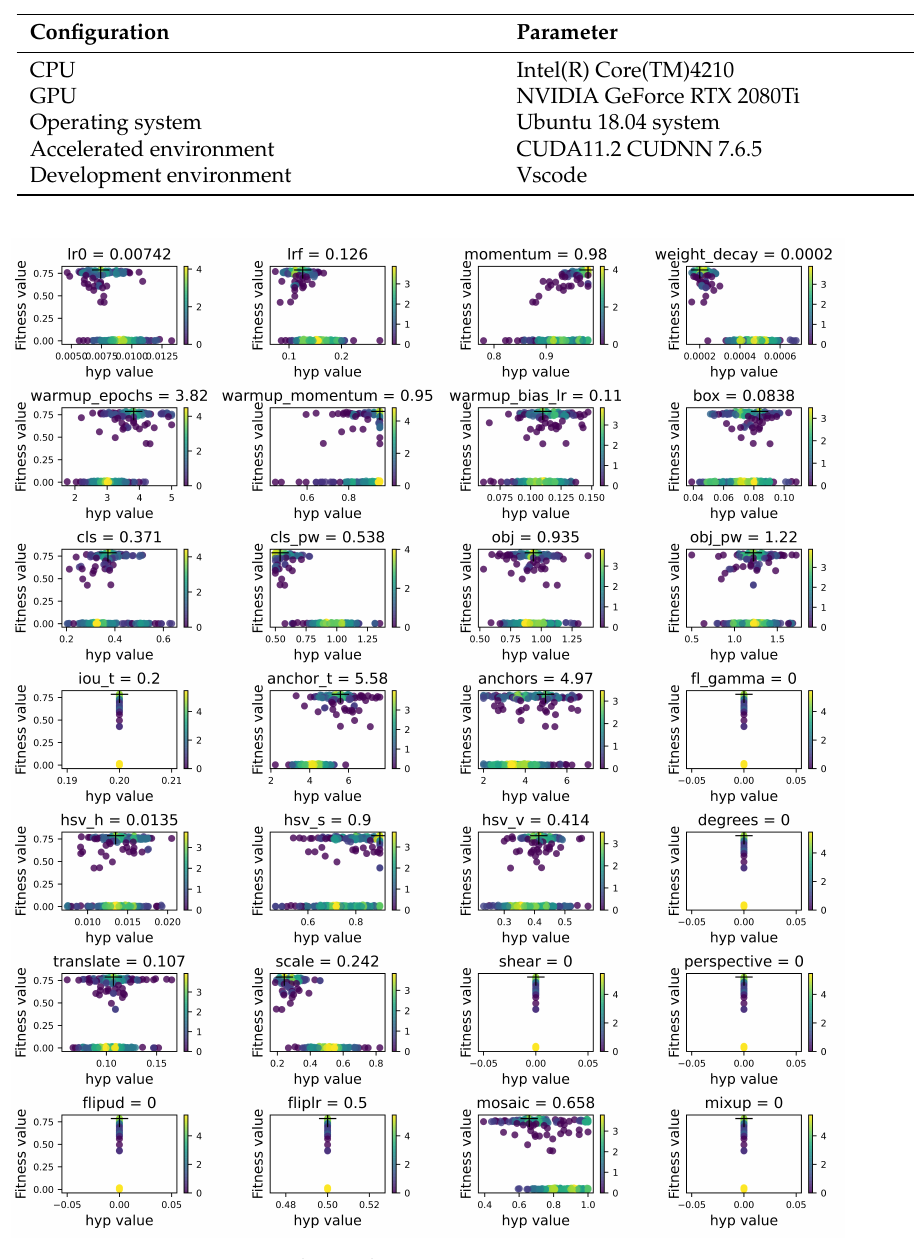
Figure 7. Hyperparameters obtained using a